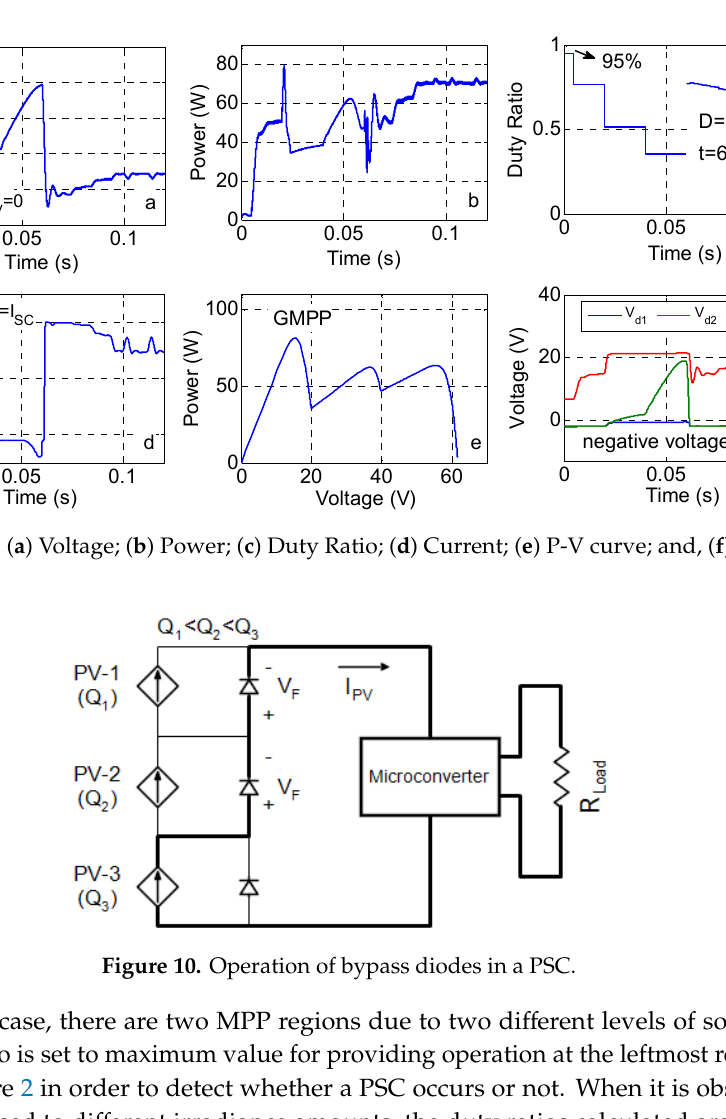
Figure 11. Case 2 ( a ) Voltage; ( b ) Power; ( c ) Duty Ratio; ( d ) Current; ( e ) P-V curve; and, ( f ) Voltage of bypass diode. 0